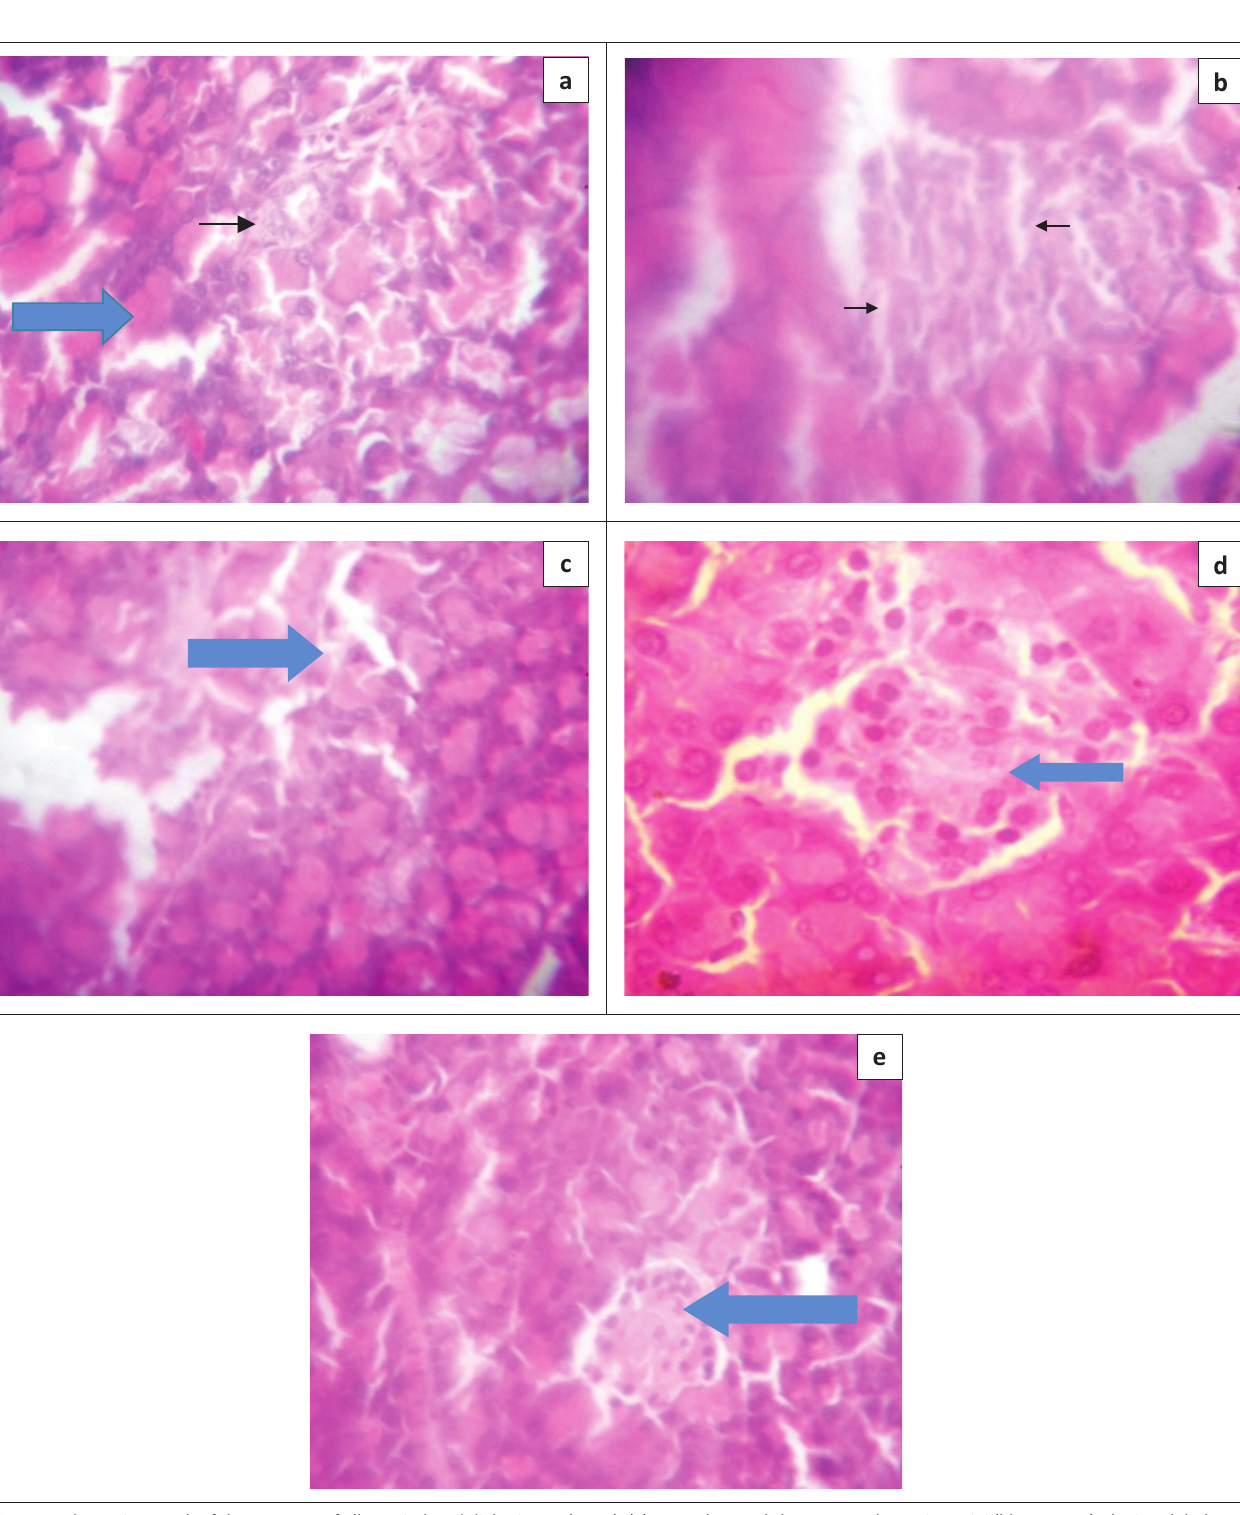
FIGURE 1: Photomicrograph of the pancreas of alloxan-induced diabetic rats ( × 400). (a) Normal control shows normal exocrine acini (blue arrows); the intralobular and interlobular ducts are essentially normal and contain pancreatic secretion (slender arrows). (b) Diabetic control shows islets in varying sizes, few and far between (slender arrows). (c) Glibenclamide-treated group shows islets in varying sizes, few and far between (blue arrows). (d) 200 mg/kg MLVA and (e) 400 mg/kg MLVA islets show hyalinisation in the centre while the remnant islet cells are limited to the periphery; these are few and far between (blue